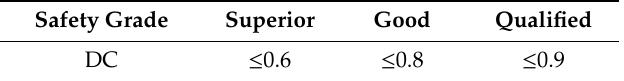
Table 2. Safety limits of the DC.